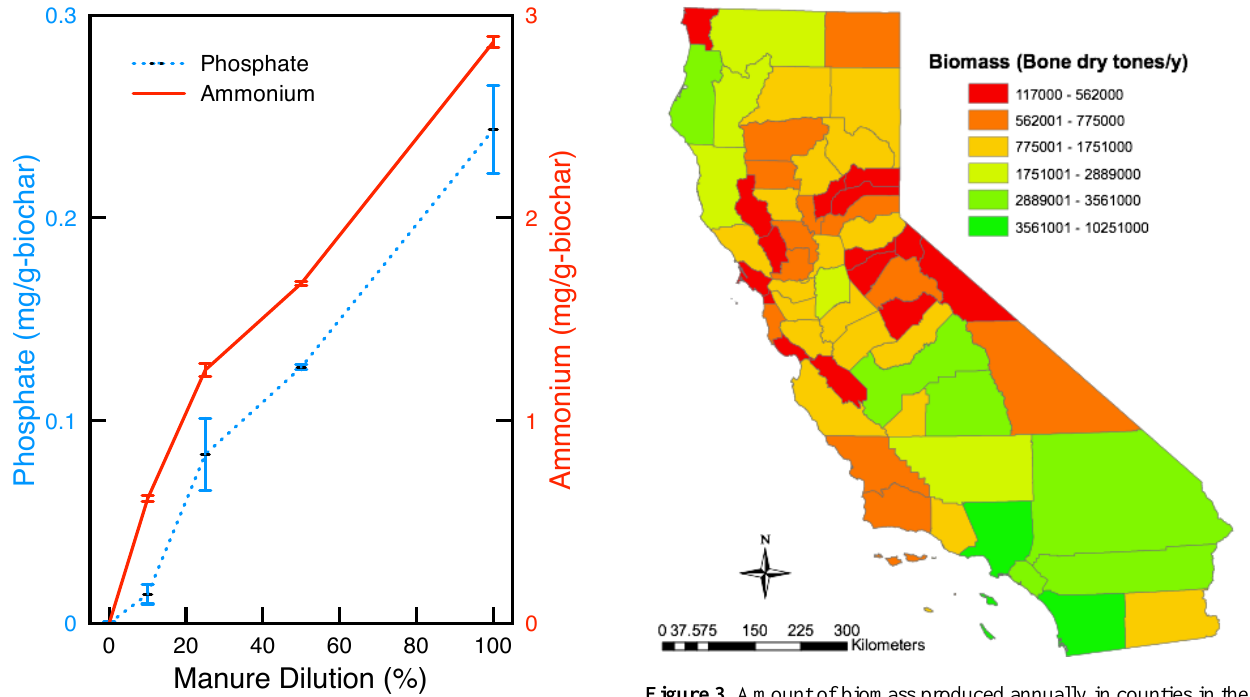
Figure 2. Recovery of ammonium and phosphate by biochar from dairy wastewater. Sorption experiments were done using biochar at the rate of 2g per 40mL solution. The experiment was conducted at manure dilutions of 10–100% of the manure in 0.001MCaCl 2 in order to capture the effect of nutrient concentration in manure on their recovery. Nutrient concentrations in manure can vary de- pending on the amount of water used to flush the manure, climate, and length of time the flushed manure has been stored in the la- goons (i.e., evaporative losses). The 100% concentration in this study equates to 714mgL − 1 ammonium and 24mgL − 1 phosphate, but higher concentrations are possible under different conditions. Error bars represent standard error where n = 4 for each batch.